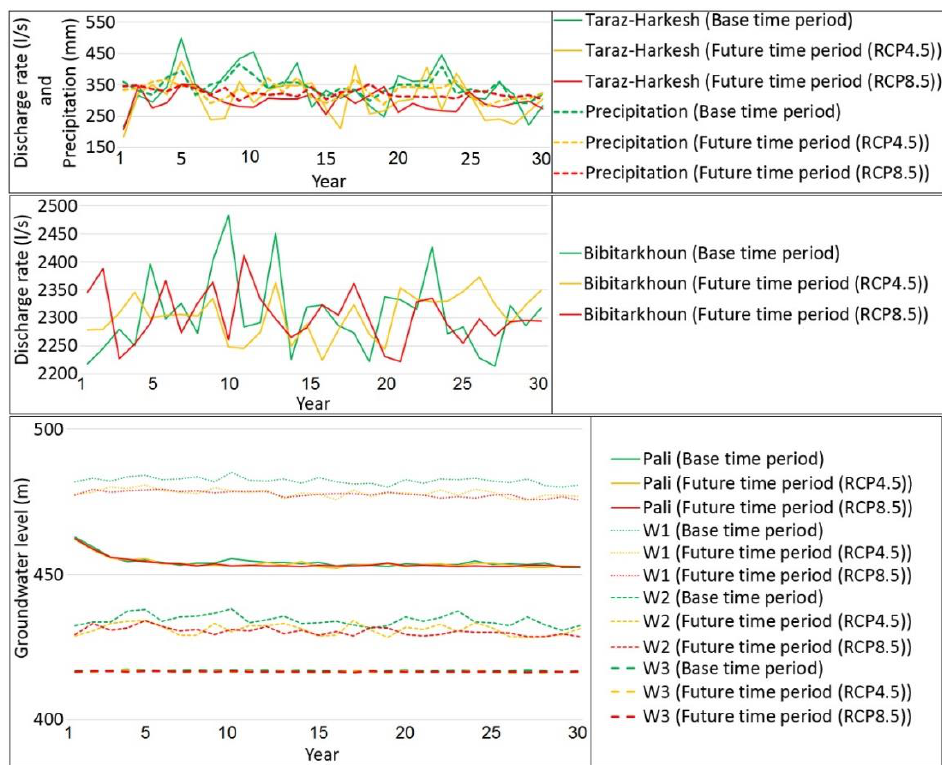
Figure 4. The annual precipitation, the discharge rates of the Taraz-Harkesh stream and the Bibitarkhoun karst spring and the groundwater level of the Pali alluvial aquifer and the karst wells (W1, W2 and W3) in the base and future time periods, considering RCP4.5 and RCP8.5 (years 1–30 indicate 1961–1991, as to the base time period and 2021–2050, as to the future time